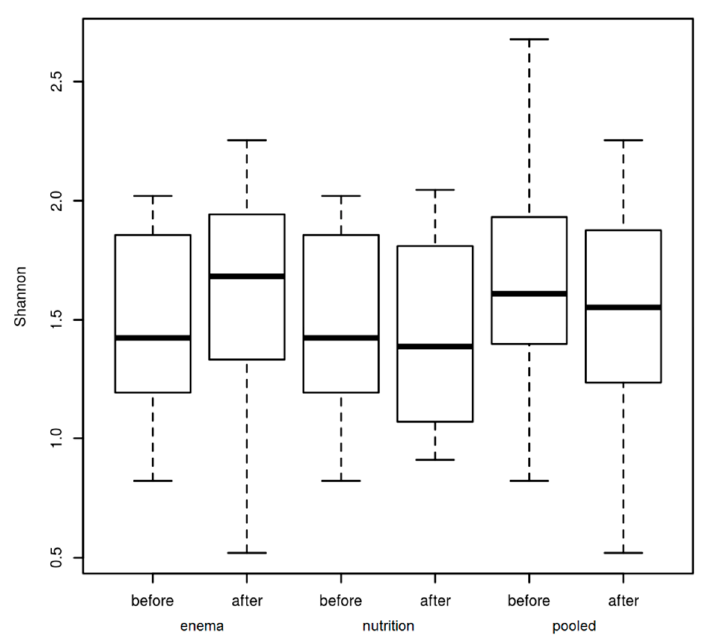
Figure 7. Shannon index before and after the 14 days of therapy for each individual group (enema, only nutrition) and for both groups together (pooled). Box-Whisker-Plots (minimum, 25%-quartile, median, 75%-quartile, maximum).